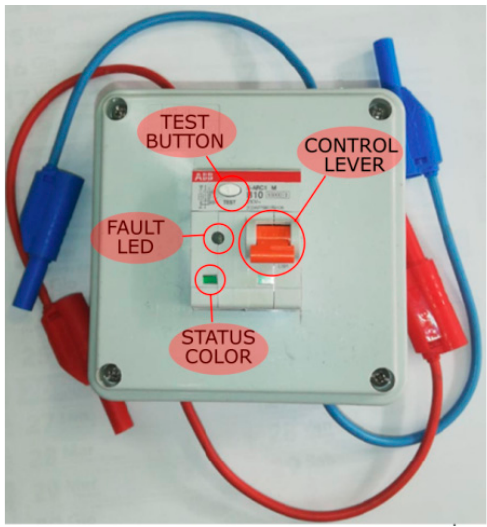
Figure 2. AFDD Abb S-arc M B10 that was used in the tests. Table 2. Limit values of the break time for a series arc.